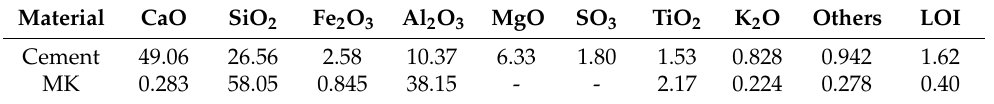
Table 1. Chemical compositions of Portland cement and Metakaolin/%.